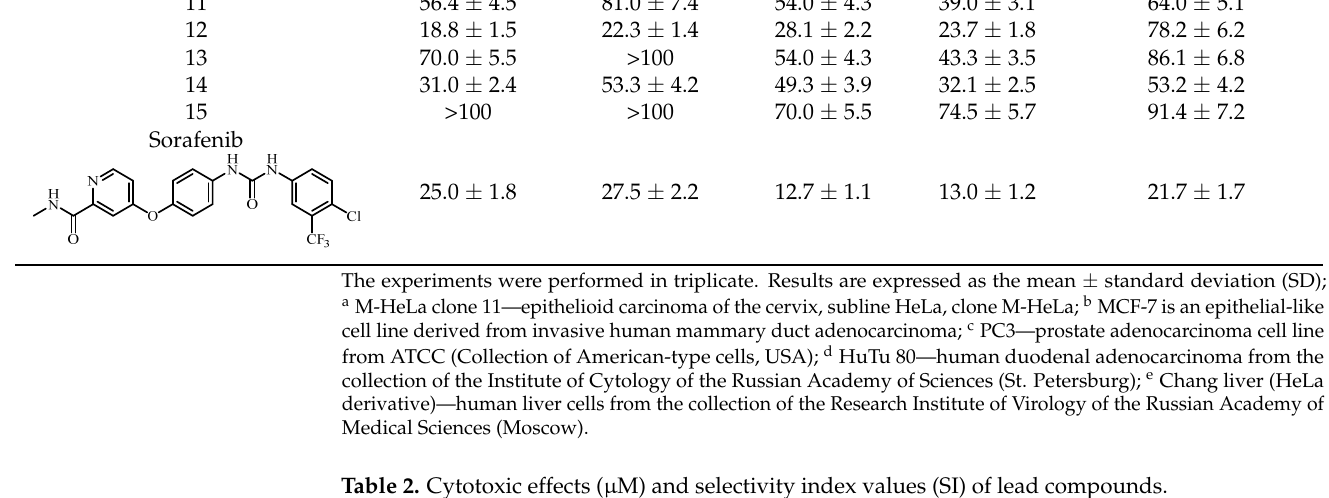
Table 2. Cytotoxic effects ( µ M) and selectivity index values (SI) of lead